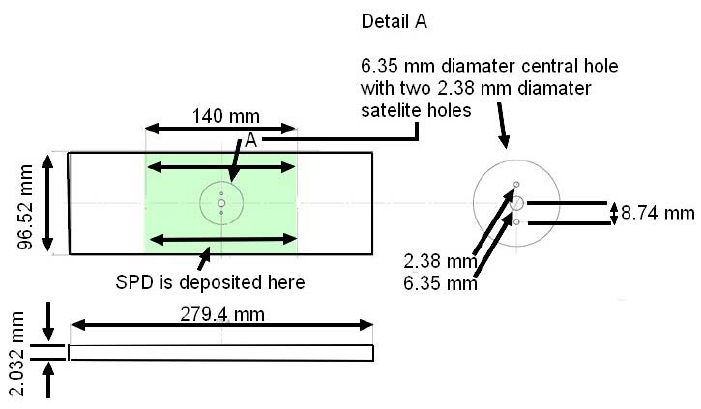
Figure 19. Schematic diagram of the supersonic particle deposition (SPD)-repaired dome nut fastener hole (DNH) coupons; from [46].